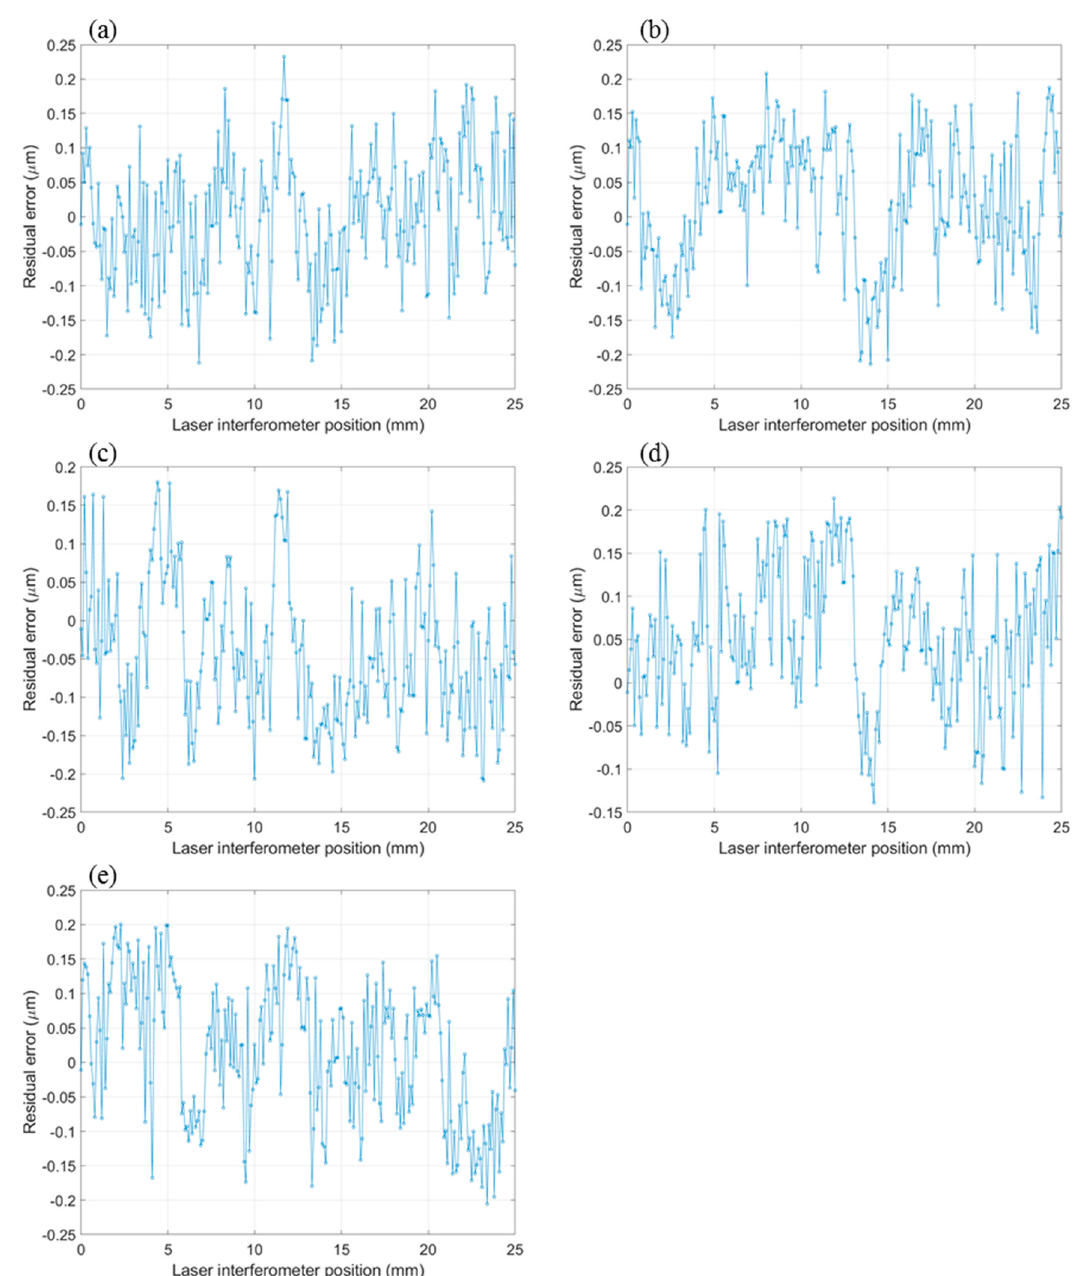
Figure 13. ( a )–( e ) Residual errors of repeated five measurements (25 mm). Figure 13. ( a – e ) Residual errors of repeated five measurements (25